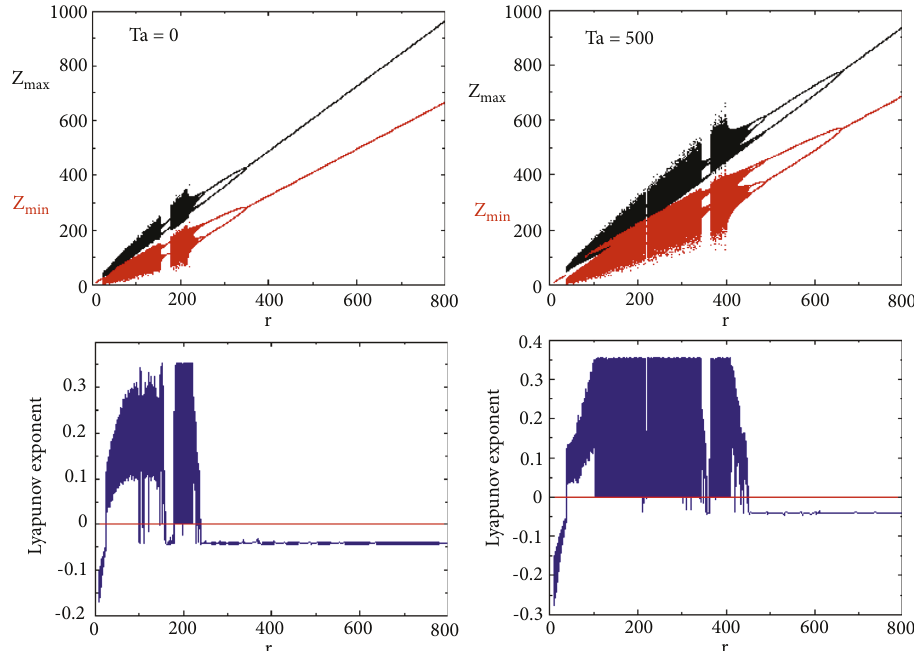
Figure 19: Bifurcation diagrams and its corresponding Lyapunov exponents for various values of Ta with Λ � 1, Da � 0, s � 0, P � 10, � √ � 1 , η � 8/3, ε � 1, and σ � − 1/3 k � π / 2 , L � M 2